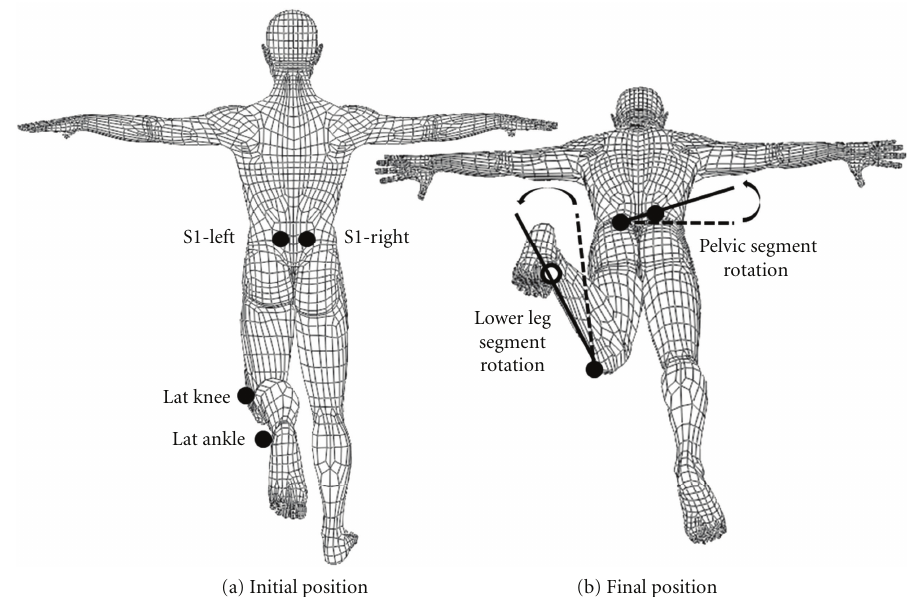
Figure 1: Hip medial rotation test and kinematic variables. (a) Posterior view of kinematic marker locations in the initial position: 7cm left (S1-L) and right (S1-R) of the first sacral vertebra, on the lateral malleolus (lat ankle), and on the lateral knee joint line (lat knee). (b) Angled posterior view of the pelvic segment, defined by a line between the S1 markers, and the lower leg segment, defined by a line between the lat ankle and lat knee, in the final position of hip medial rotation. Lumbopelvic rotation was assessed by the angular excursion of the pelvic segment in the transverse plane between the initial and final positions. Hip medial rotation was assessed by the angular excursion of the lower leg segment in the transverse plane relative to the lumbopelvic rotation between the initial and final positions. Dotted lines indicate initial positions, and solid lines indicate final positions. Open circles indicate markers obscured from